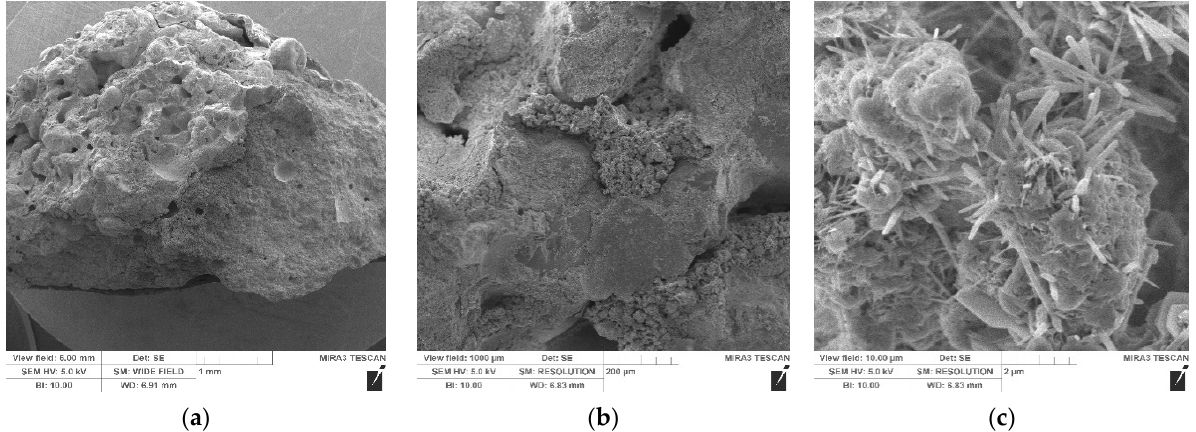
Figure 4. Microstructure of the cleavage surface of the 0.63 + 15% CB-2 specimen cube in the zone of the contact layer under various magnifications: ( a ) 5 mm; ( b ) 1000 μ m; ( c ) 10 μ m.